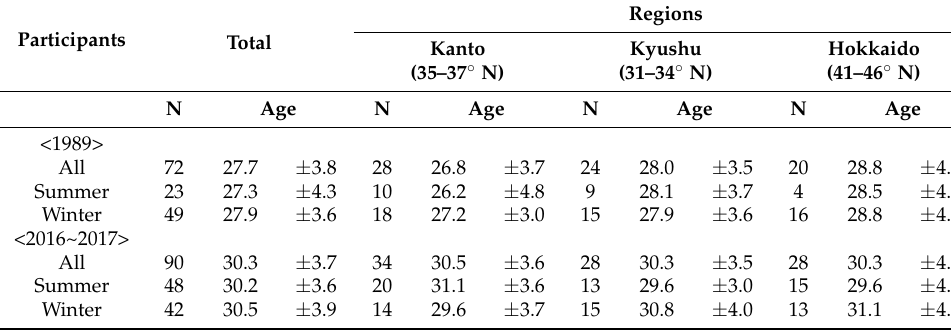
Table 1. Number and age of lactating mothers in 1989 and 2016–2017.